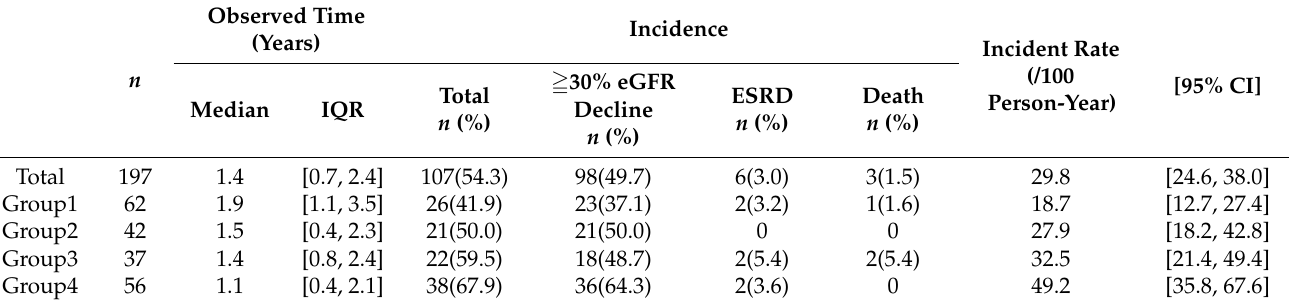
Table 2. Incidence of eGFR (cid:61) 30 % decline or renal replacement therapy or death.